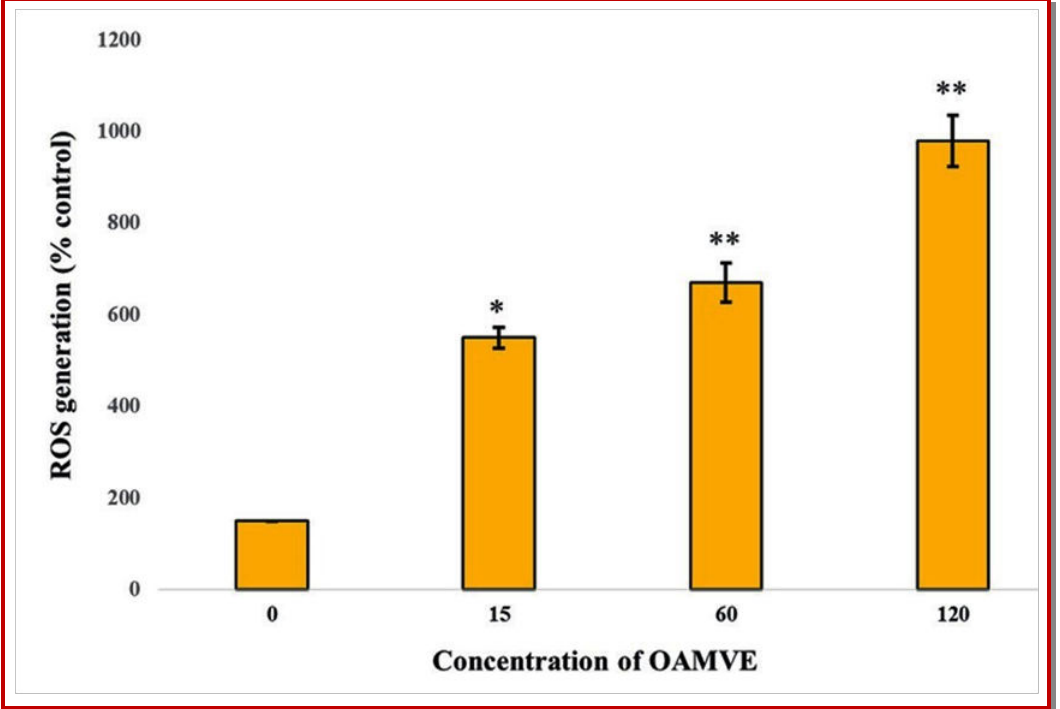
Figure 3: Oleanolic acid methyl vanillate ester (OAMVE) induced ROS generation in HeLa cervical cancer cells. HeLa cells were treated with OAMVE (0, 15, 60 and 120 µM) for 2 hours, and the ROS generation was estimated using CM-DCFH2-DA staining by flow cytometry. **p<0.01 vs. control group